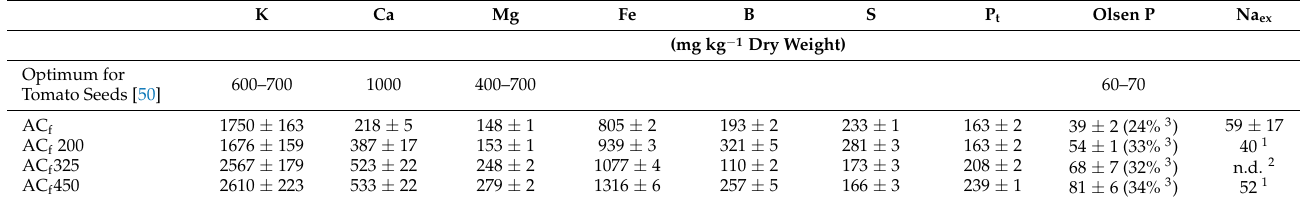
Table 7. Contents (mg kg − 1 ) of total K, Ca, Mg, Mn, Zn, B, S and P as well as Olsen P and exchangeable Na (Na ex) of the fine feedstock from Acrocomia aculeata and the respective biochars pyrolyzed at 200, 325 and 450 ◦ C (mean ± standard error, n = 3). Contents of Cu and Mn were below detection level. Zn concentration was <2.4 mg kg − 1 dry